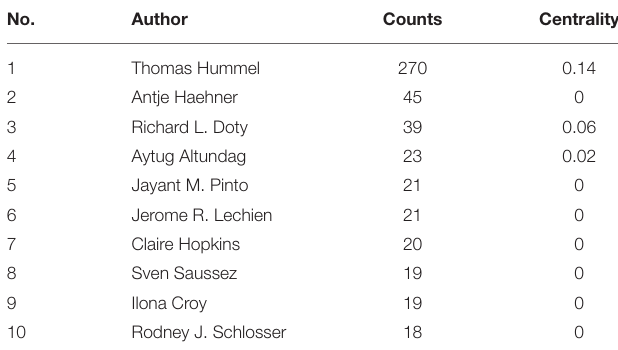
TABLE 3 | Top 10 most active authors in the field of olfactory dysfunction from 2002 to 2021.